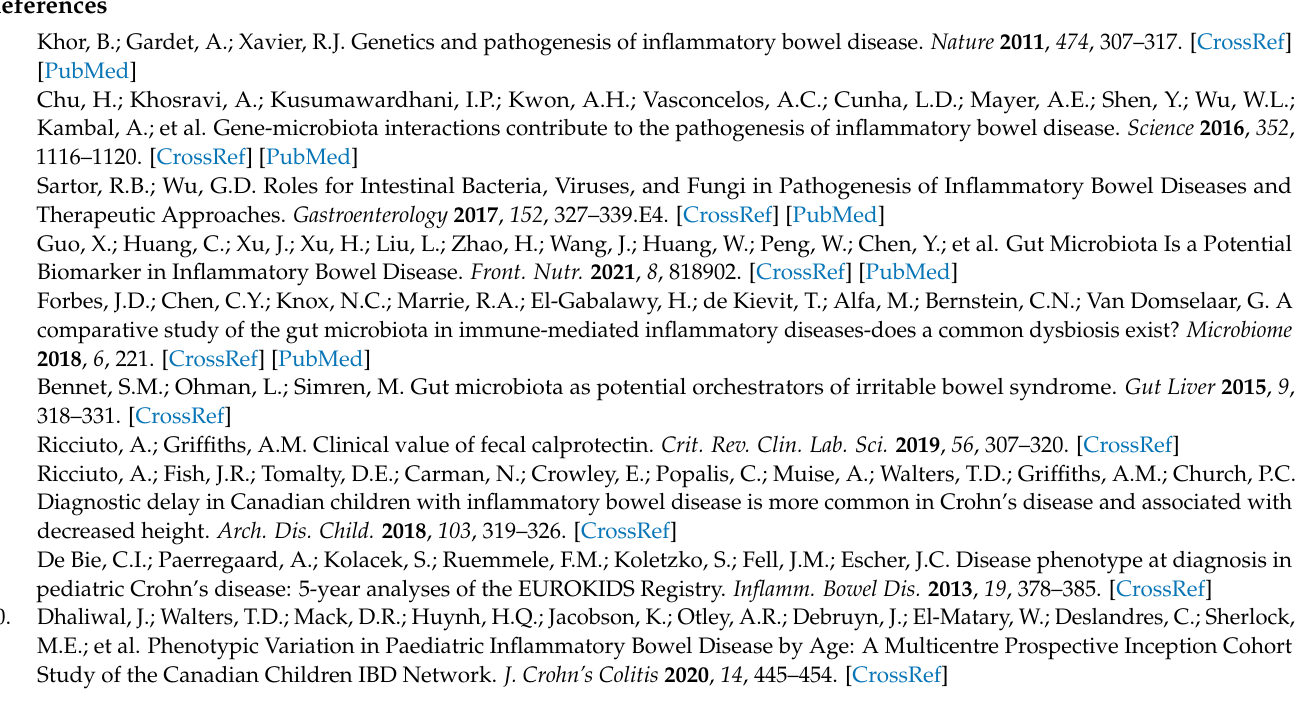
Table S2: The 104 species targeted by PMPTM panels. The PMP TM qPCR probes are specific for the commercially available DMSZ and ATCC bacteria species genomes listed, and standard curves are made for each reference genome to enable the quantification of the bacteria species. Figure S1: Area Under Precision-Recall curve for the Diagnostic Index 1. Figure S2: Area Under Precision-Recall Curve for the Diagnostic Index 2. Figure S3: Area Under Precision-Recall Curve for the Diagnostic Index 3. Figure S4: Area Under Precision-Recall Curve for the Phenotype Index. Figure S5: Area Under Precision-Recall Curve for the Prognostic